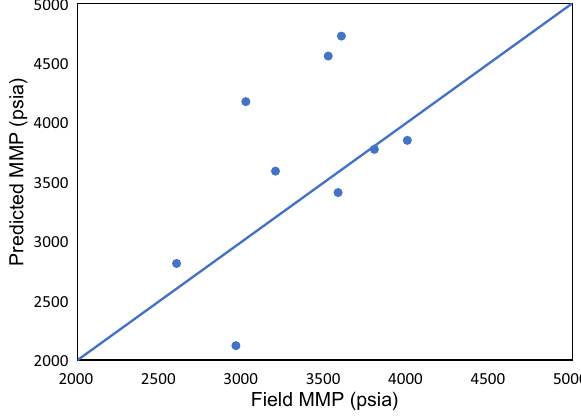
Fig. 10 Cross-plot of MMP testing data for He (2020)